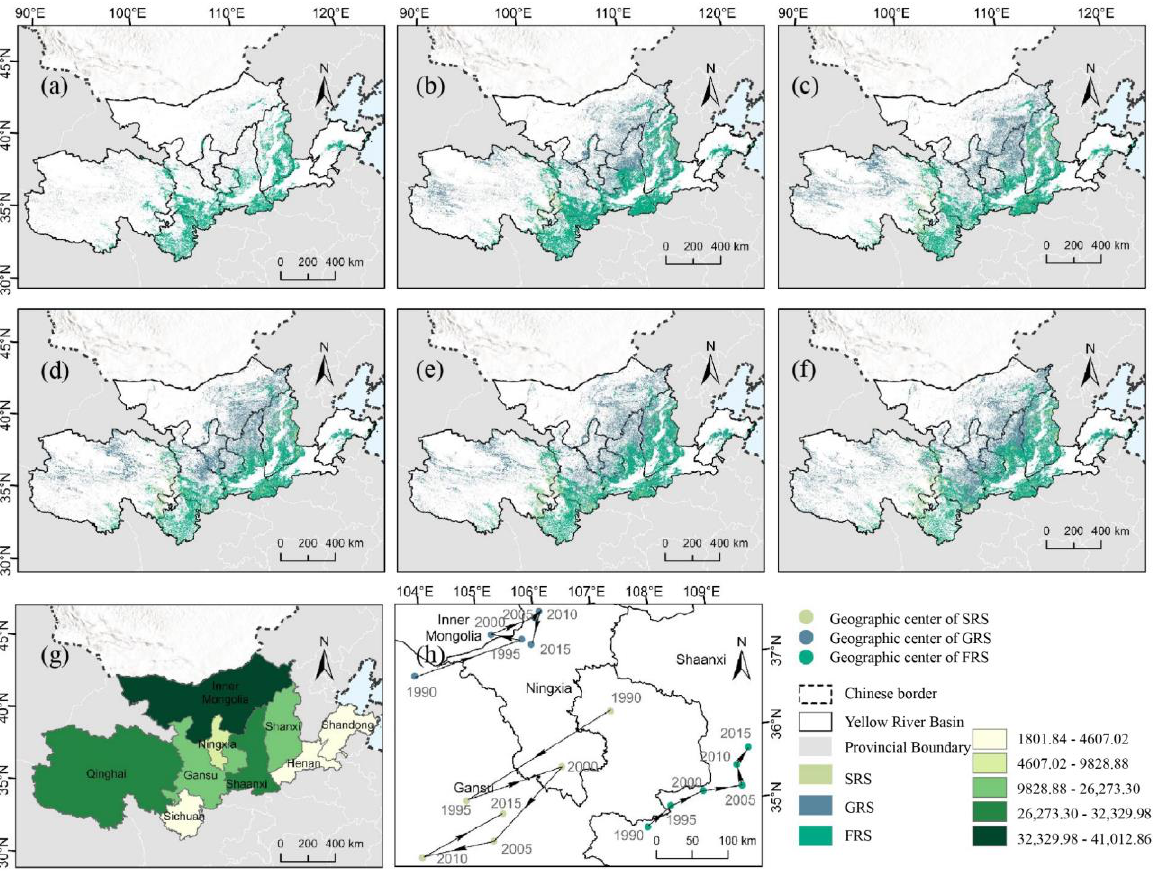
Figure 4. Spatiotemporal pattern and evolution of ERS. ( a – f ) spatial distribution pattern of ERS in 1990, 1995, 2000, 2005, 2010, and 2015, respectively; ( g ) the cumulative area of ERS by province for 1990 to 2015, km 2 ; ( h ) distribution of interannual migration pattern of geographic center of GRS, FRS, and SRS from 1990 to 2015.